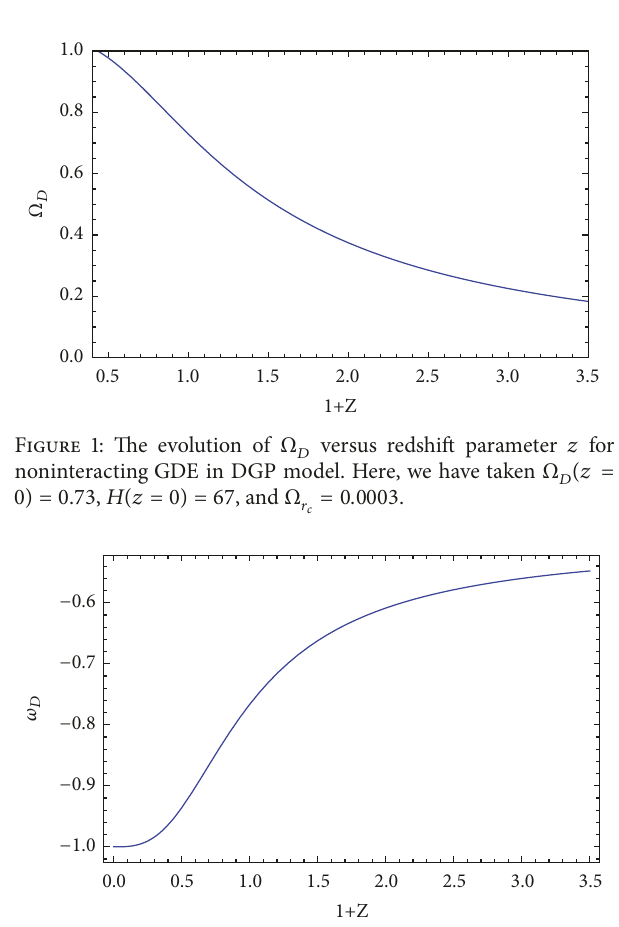
Figure 2: The evolution of 𝜔 𝐷 versus redshift parameter 𝑧 for noninteracting GDE in DGP model. Here, we have taken Ω 𝐷 (𝑧 = 0) = 0.73 , 𝐻(𝑧 = 0) = 67 , and Ω = 0.0003 𝑟 𝑐